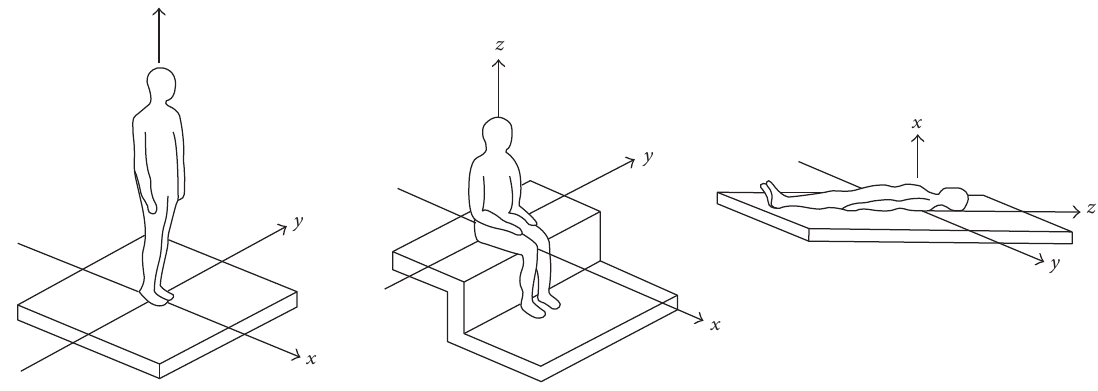
Figure 2: Vibration propagation axes as defined in UNI 9614 [14].